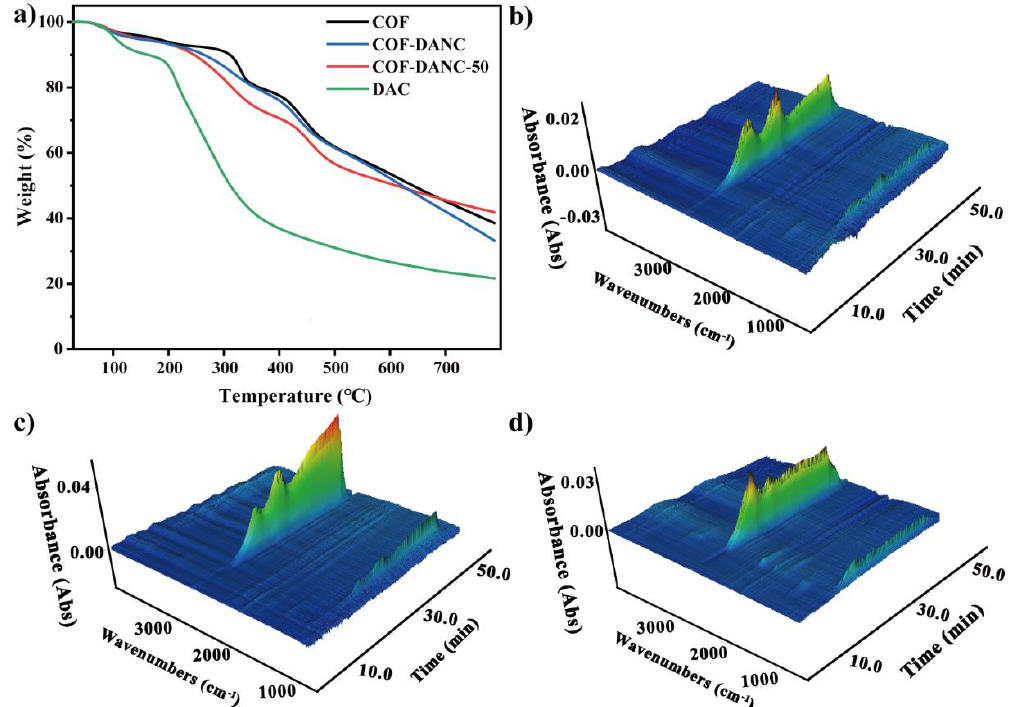
Figure 5. ( a ) the thermogravimetric curve of different materials; ( b – d ) the thermogravimetric infrared three-dimensional diagrams of ( b ) COF-TpPa-1, ( c ) TpPa-DANC-50 composites and ( d ) COF monomer mixing.